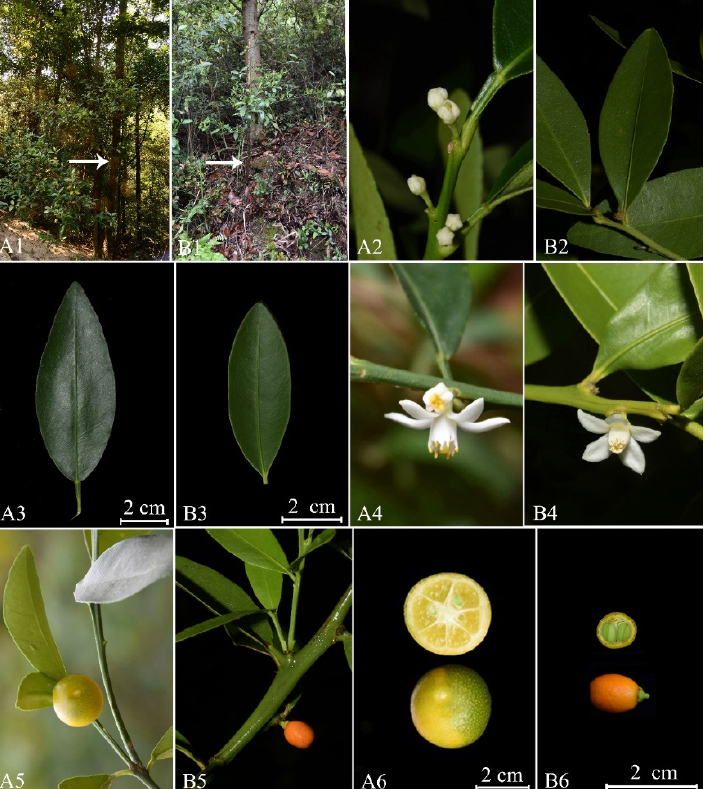
Figure 11. Main morphological forms of Fortunella japonica and F. venosa . ( A ). F. japonica ; ( B ). F. venosa . 1 . Plants and habitats; 2 . Branches; 3 . Leaves; 4 . Flowers; 5 . Fruit branches; 6 . Fruits and fruits cross-cut.